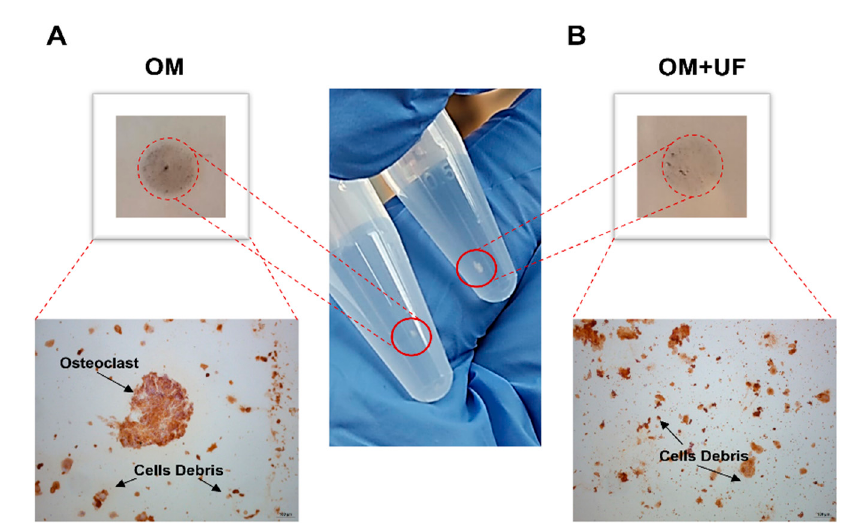
Figure 6. Effects of UF on the control hOBs/hOCs 3D-DyC Co-Culture System: hOCs and hOBs were co-cultured in microgravity in a 3D system bioreactor (RCCS-4TM) for 14 days in the ( A ) presence or ( B ) absence of UF (10 µ M). Representative images of cell aggregates and TRAP analyses were reported.